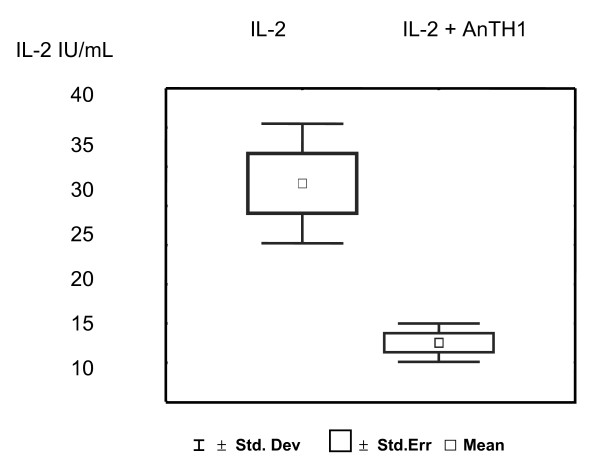
Inhibition of growth stimulating activity of rhu IL-2 on the mouse cell line CTTL-2 by recombinant chimeric protein. The data are results from 3 independent experiments. The observed difference proved to be statistically different (p < 0.05) by the Kruskal-Wallis test. IL-2 dilution 1:40 000 correspond to 25 IU/mL (2.8 ng/mL). Group1: IL-2, group 2: IL-2 + TH1 antagonist. Results expressed in international units of IL-2 where 1 IU is defined as the amount of IL-2 that elicits a 50% increase in cell growth in a cell base bioassay.